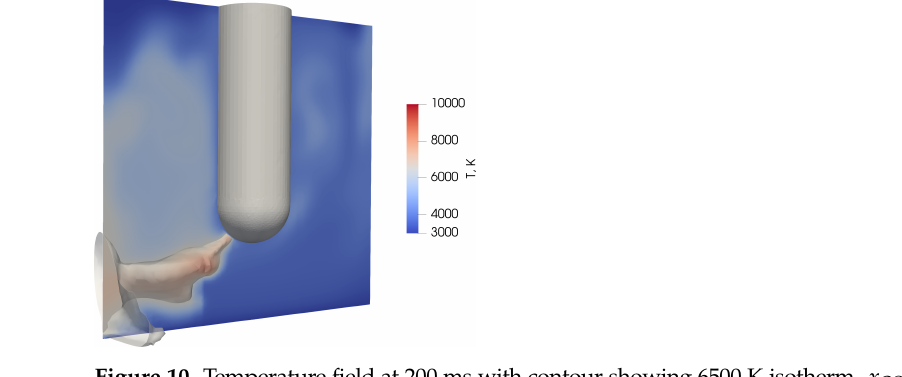
Figure 10. Temperature field at 200 ms with contour showing 6500 K isotherm. x CO = 0.7, L a = 0.05 m and I = 1000